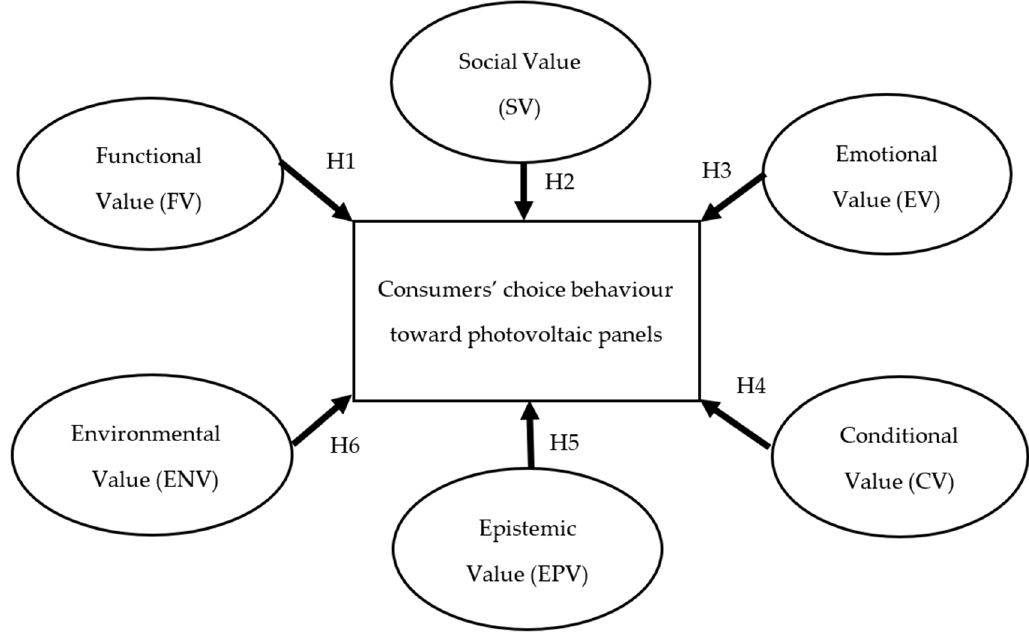
Figure 1. Conceptual model.